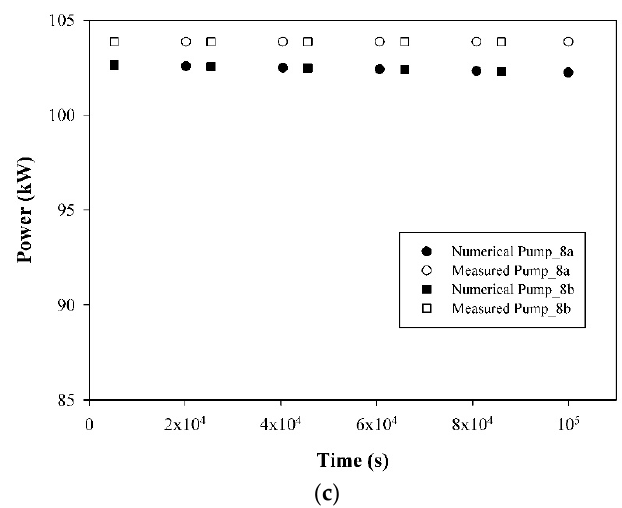
Figure 3. Numerical and measured pump power ( a ) pump group 1, ( b ) pump group 2 and ( c ) pump group 3.